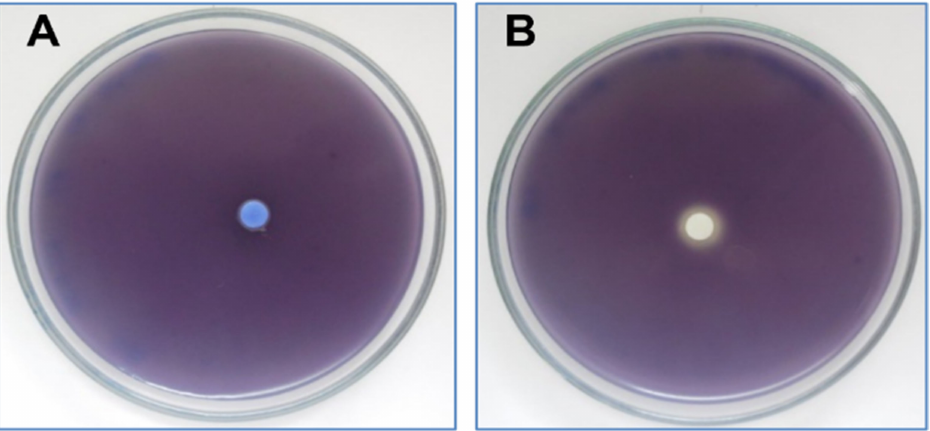
Figure 4. ( A ) Effect of caraway essential oil on violacein production by C. violaceum CV026 tested on Lauria–Bertani agar as compared to limonene at 2 mg/disc ( B